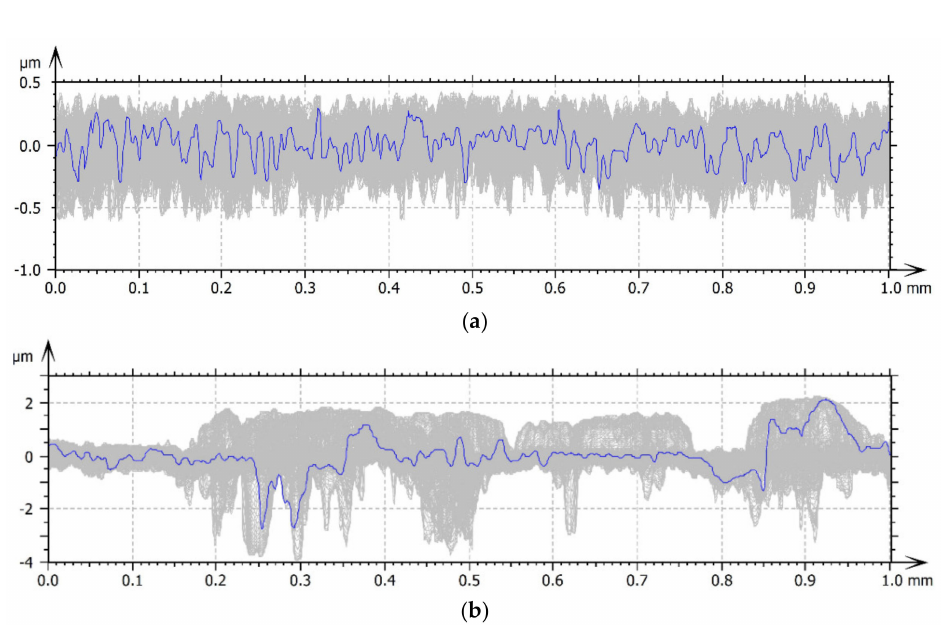
Figure 2. Series of profiles: ( a ) Surface A, ( b ) Surface